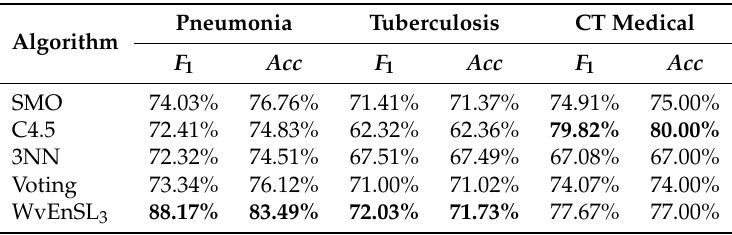
Performance evaluation WvEnSL 3 against state-of-the-art supervised algorithms on Pneumonia dataset, Tuberculosis dataset and CT Medical